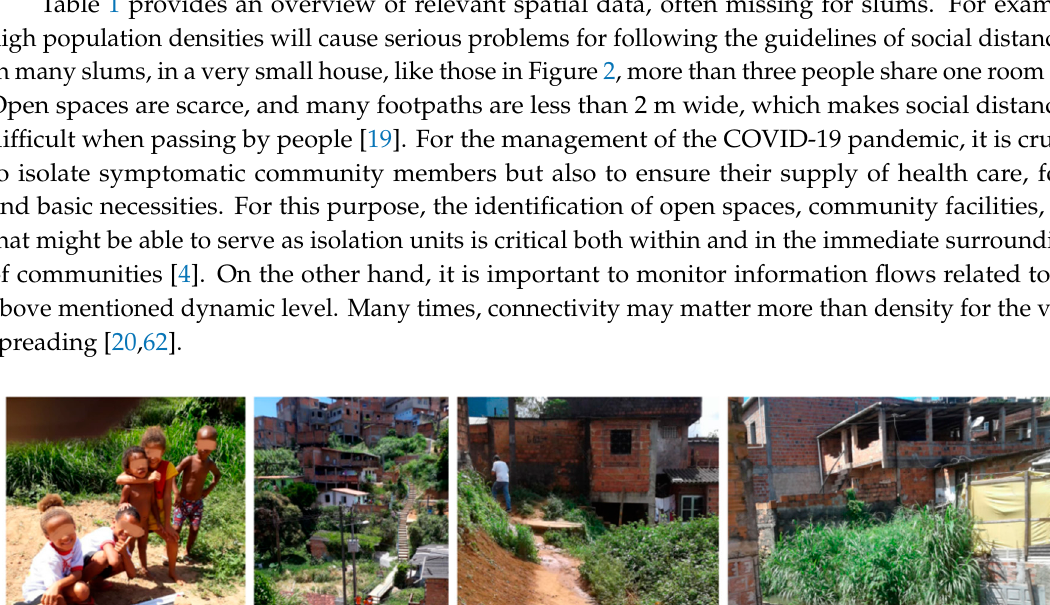
Table 2. Relevant global data and local repositories relevant to provide base data for COVID-19 responses for the example of Salvador, Brazil (for non-EO experts). Data